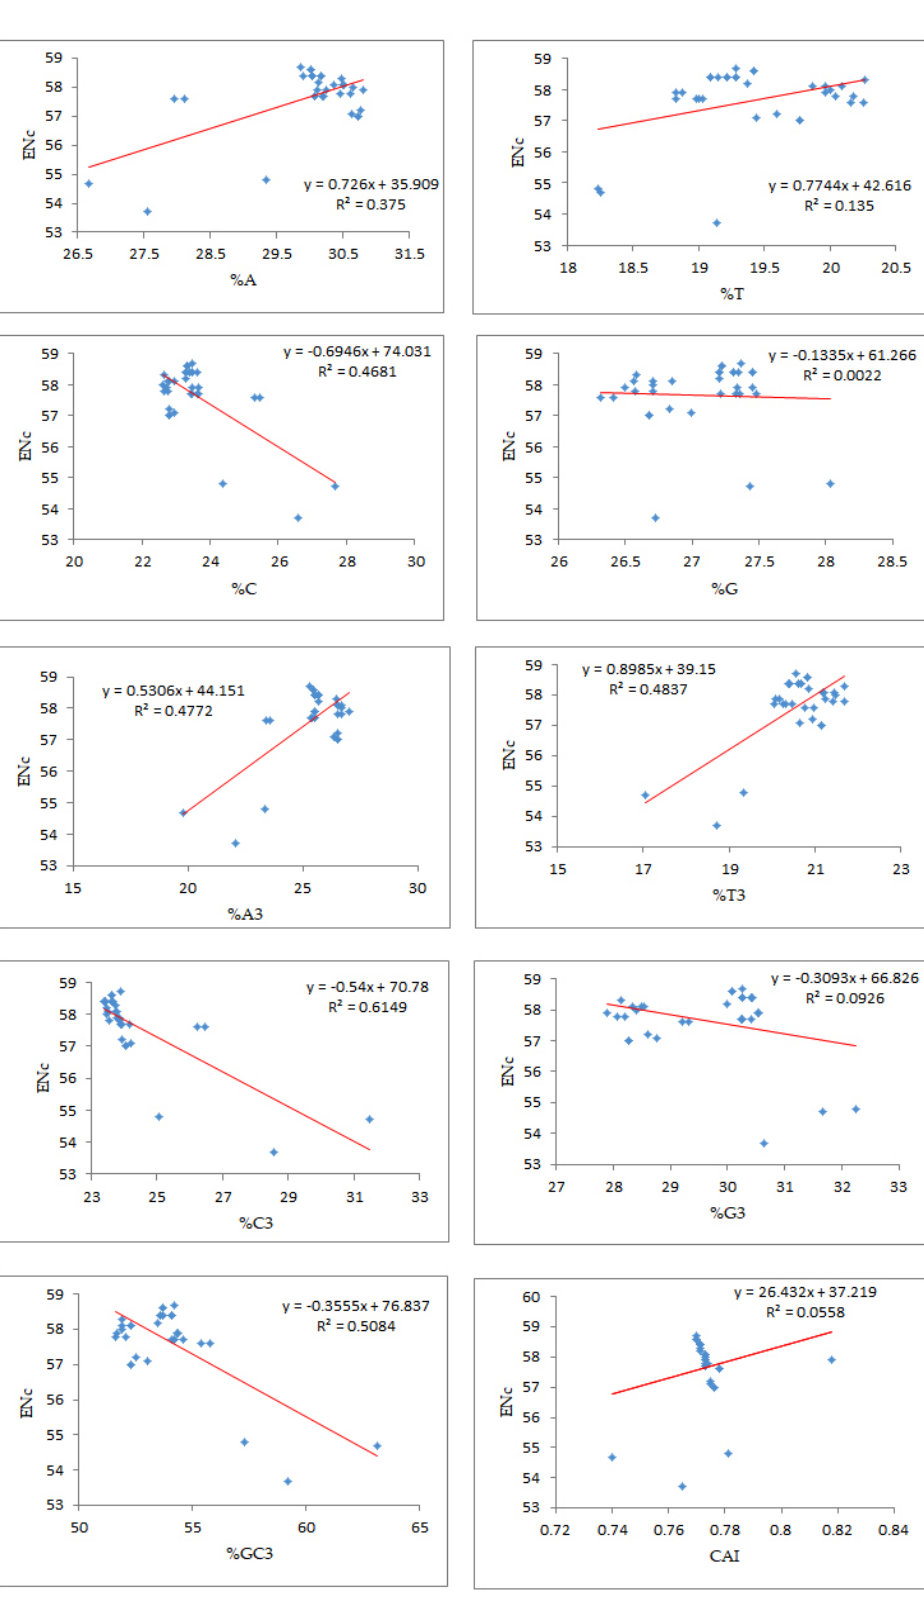
Figure 8. Regression analysis of the ratio of the ENc and the compositional properties, %GC3, and CAI.